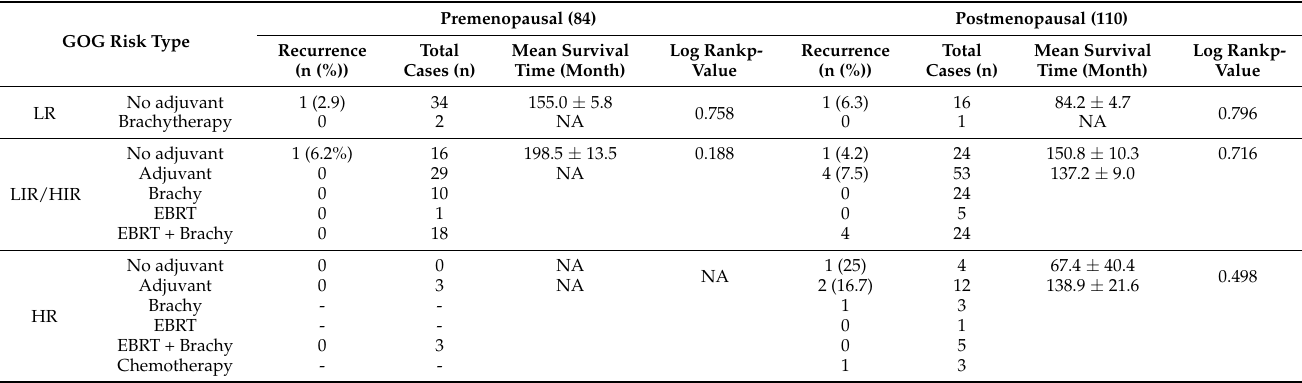
Table 5. Recurrences and mean survival time by the Gynaecology Oncology Group (GOG) in stage 1 endometrial cancer in Hospital Melaka from